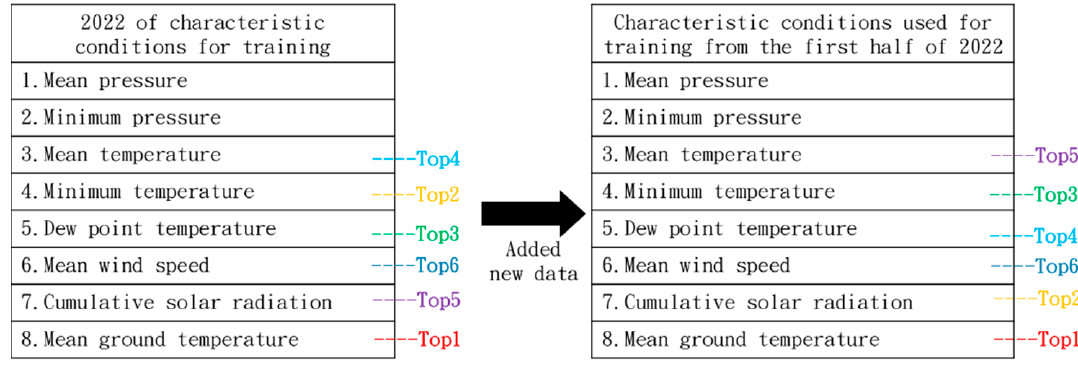
Figure 6. Correlation between climate characteristics and pest activity.